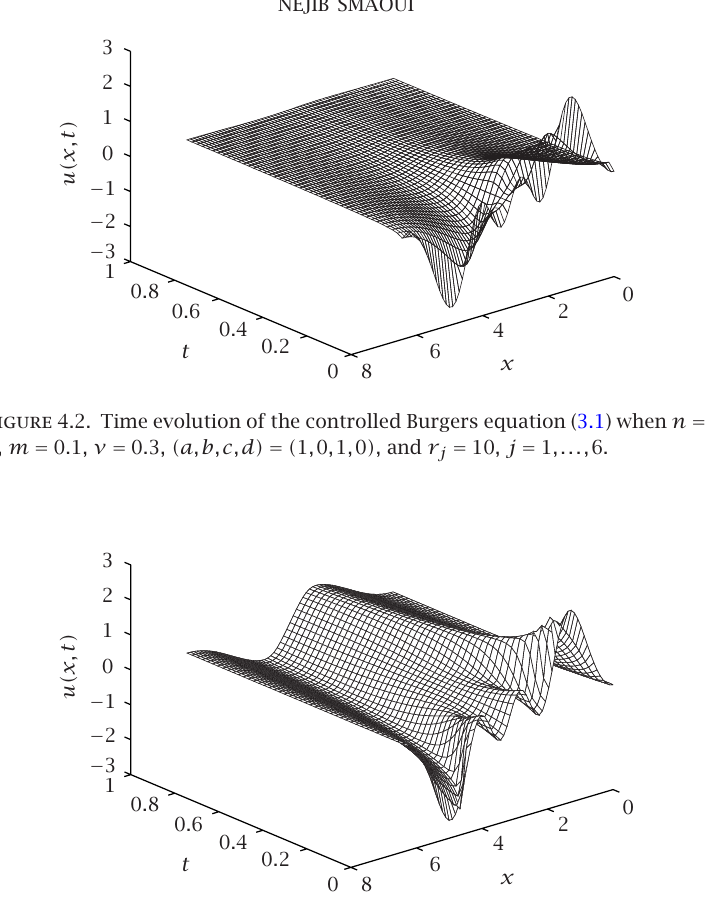
Figure 4.3 . Time evolution of the uncontrolled Burgers equation (3.1) when n = 3, m = 0 . 1, ν = 0 . 3, and (a,b,c,d) = ( 1 , 0 , 1 , 0 ) .